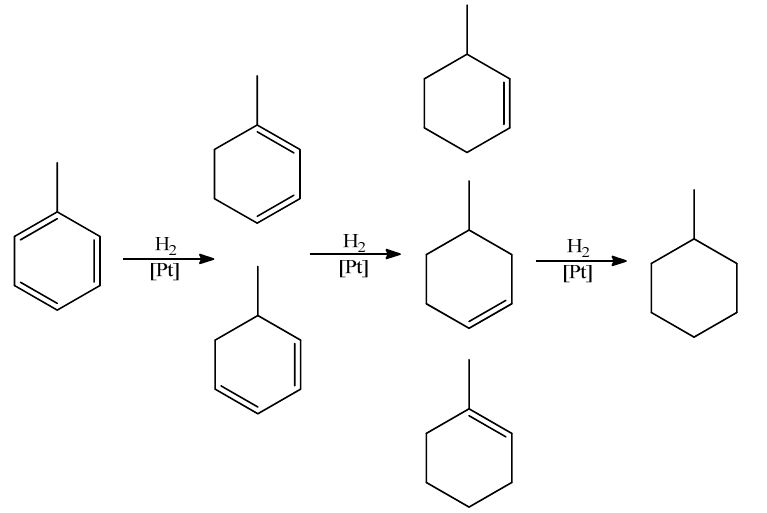
Figure 1. Reaction scheme for the hydrogenation of toluene.